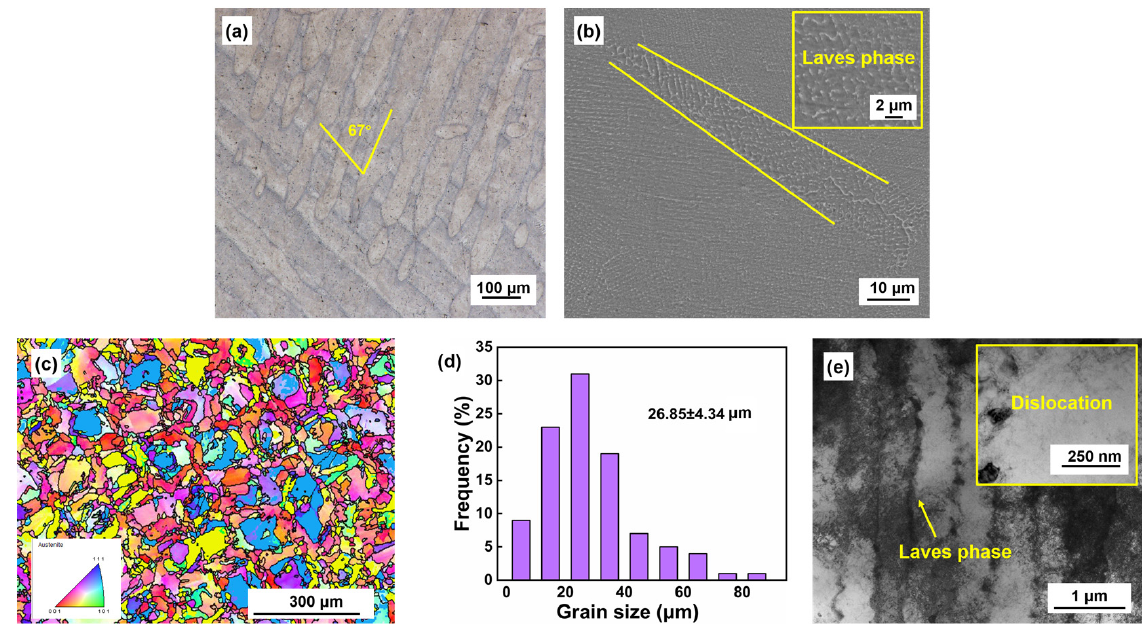
Figure 6. The microstructure of AB samples in X-Y direction: ( a ) OM morphologies; ( b ) SEM image; ( c ) an EBSD inverse-pole figure (IPF) map; ( d ) grain size distributions; ( e ) TEM image.